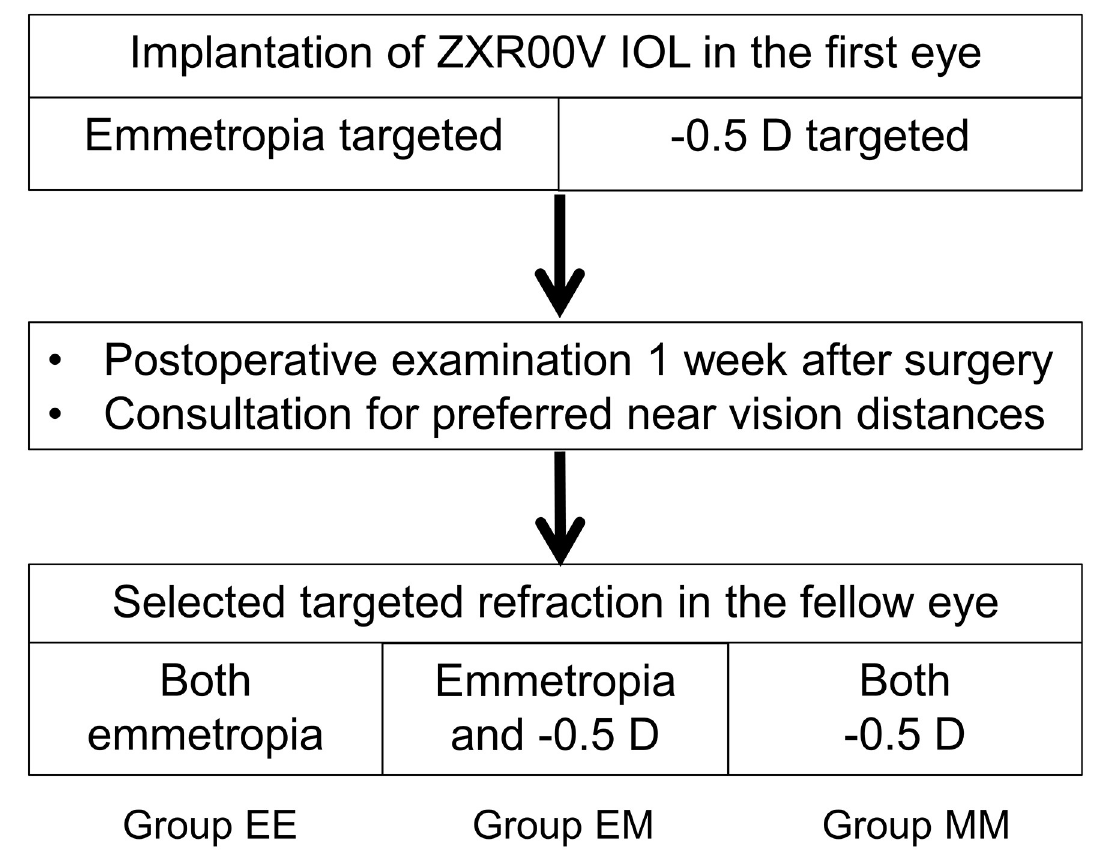
Fig 1. Staged implantation of an extended-depth-of-focus intraocular lens (IOL, ZXR00V) targeting emmetropia and -0.5 diopter (D). The patients are divided into three groups based on the choice of the target refractions: bilateral emmetropia (group EE), bilateral -0.5 D (group MM), and emmetropia and -0.5D (group EM).